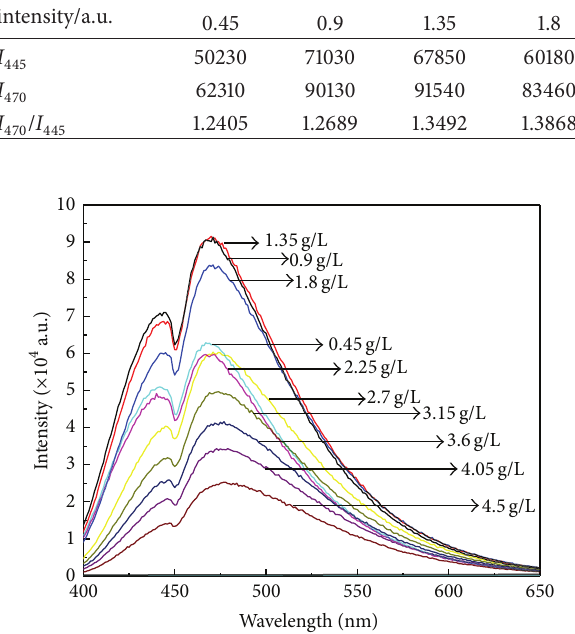
Table 1: The fluorescence intensities and intensities ratio with different concentrations of two peaks. Among them, “a.u.” indicates arbitrary units. intensity/a.u.